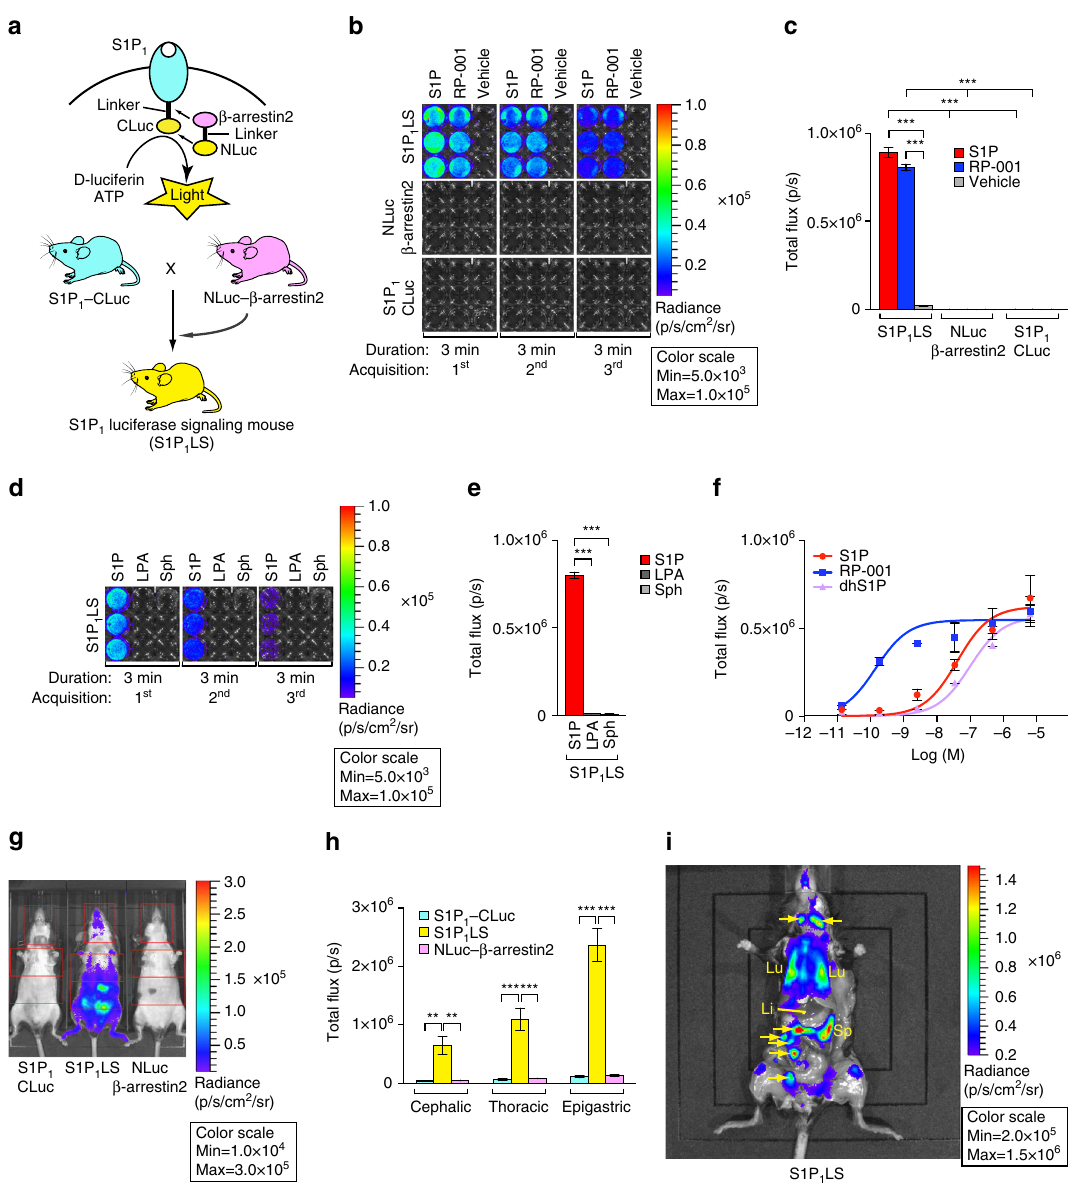
Fig. 1 Generation of S1P 1 luciferase signaling mice and detection of S1P 1 activation. a (top), Schematic of the fi re fl y split luciferase complementation design to monitor S1P 1 – β -arrestin2 interactions. a (bottom), Mouse mating scheme to derive the S1P 1 luciferase signaling (S1P 1 LS) mice. b – f Activation of S1P 1 in MEFs. b S1P 1 luciferase signaling (S1P 1 LS) MEFs heterozygous for the S1P 1 – CLuc allele and homozygous for the NLuc – β -arrestin2 allele, MEFs